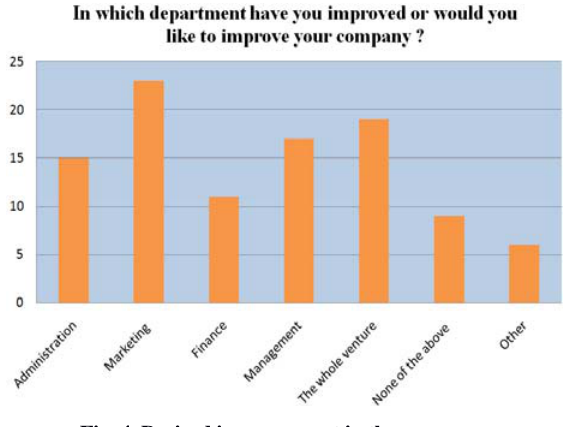
Fig. 4. Desired improvement in the company